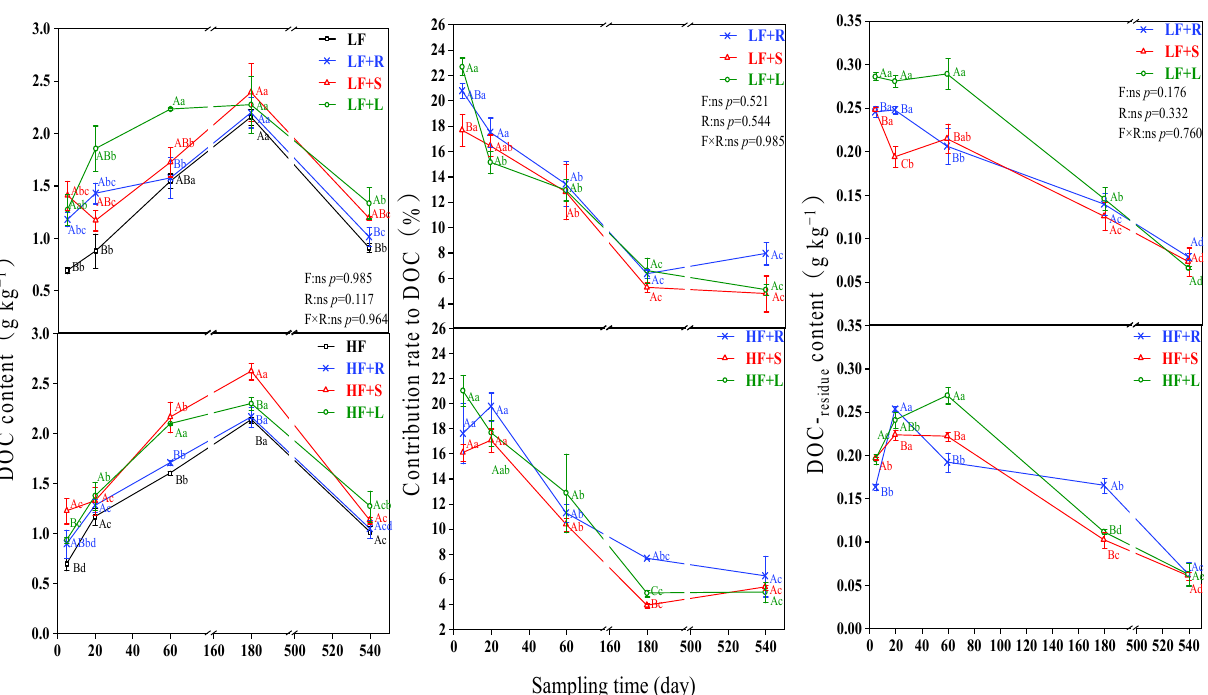
Figure 3. Distribution of different straw residues in DOC in different fertility soils over 540 days of the experiment. DOC- residue represents the content of carbon derived from different residue types in DOC. LF and HF represent low- and high-fertility soil levels, respectively. R in blue, S in red and L in green represent the residues of root, stem and leaf, respectively. Error bars represent the standard deviations from the mean (n = 3). F, R and F × R in black represent fertility level, residue type and the interaction of fertility level and residual type. ns indicates no significant difference by ANOVA analysis, respectively. Different uppercase letters indicate significant differences between different treatments in the same sampling time, while different lowercase letters indicate significant differences between di ff erent sampling times in the same treatment ( p < 0.05).